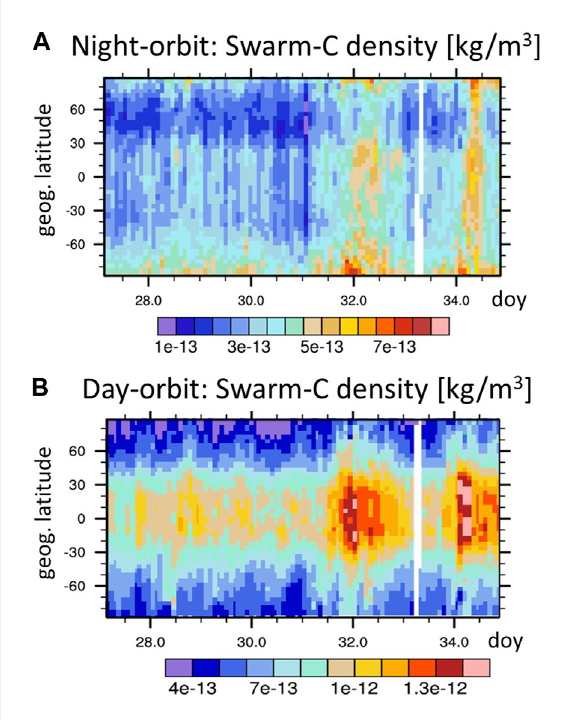
FIGURE 3 Neutral density [ kg / m 3 ] at Swarm-C orbit binned in latitude and time: (A) . For the night-time orbit, (B) . For day-time